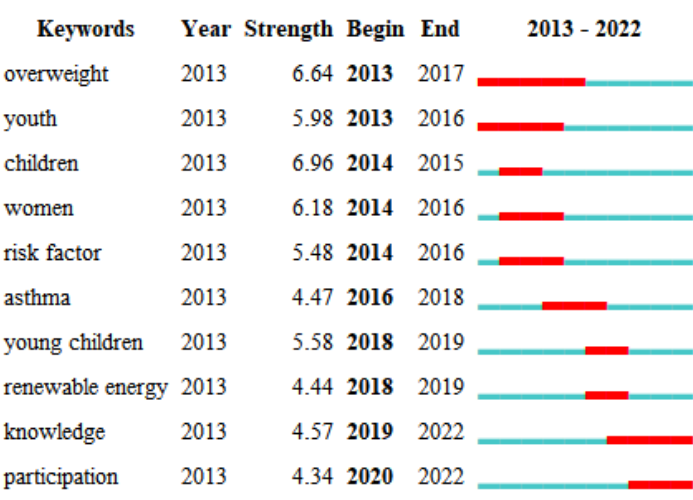
Figure 18. Keywords of rural human settlement environment research.